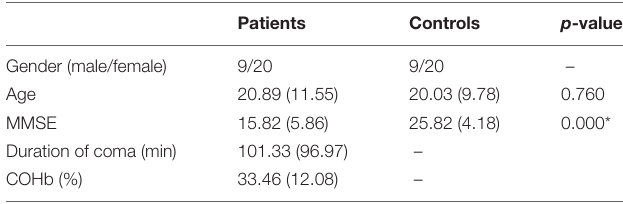
TABLE 1 | Participant demographic and clinical